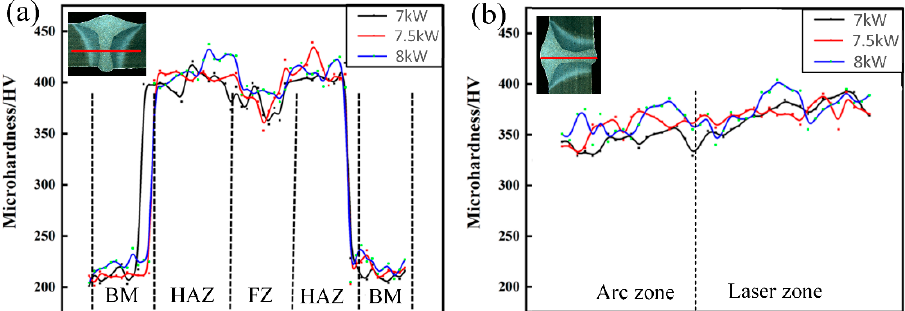
Figure 19. Hardness curves of laser-MIG hybrid welded joints under different laser powers: ( a ) weld center along the cross-section direction; ( b ) weld center along the depth direction.